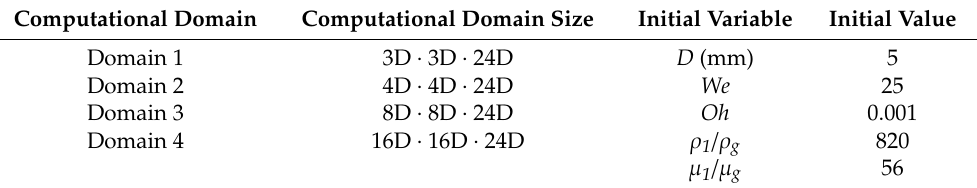
Table 1. Computational domain and initial condition setting.